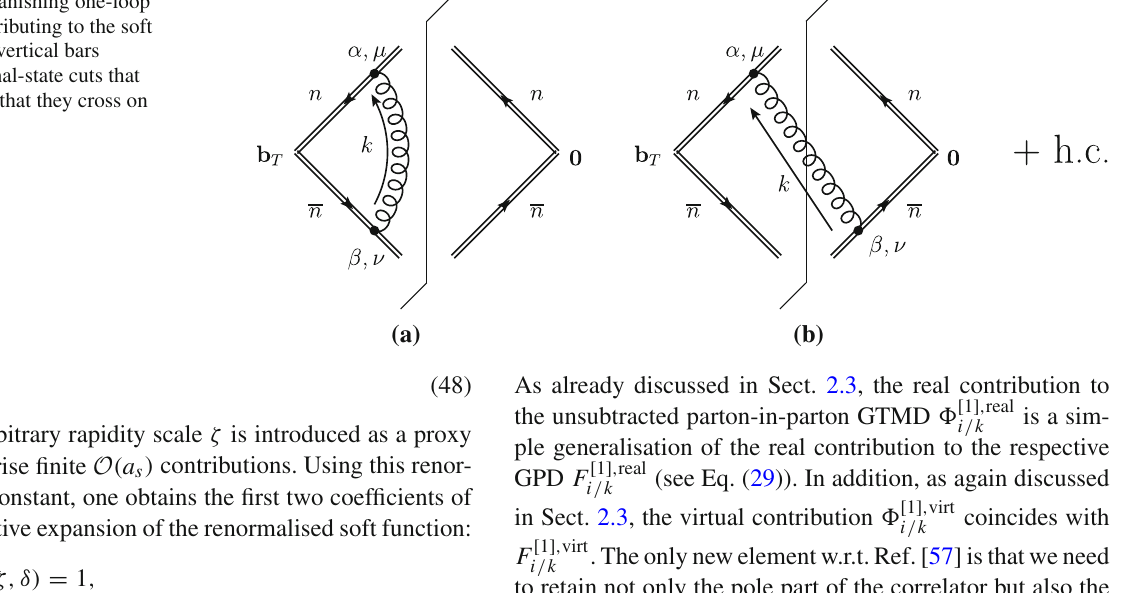
Fig. 3 Non-vanishing one-loop diagrams contributing to the soft function. The vertical bars indicate the final-state cuts that set all partons that they cross on the mass